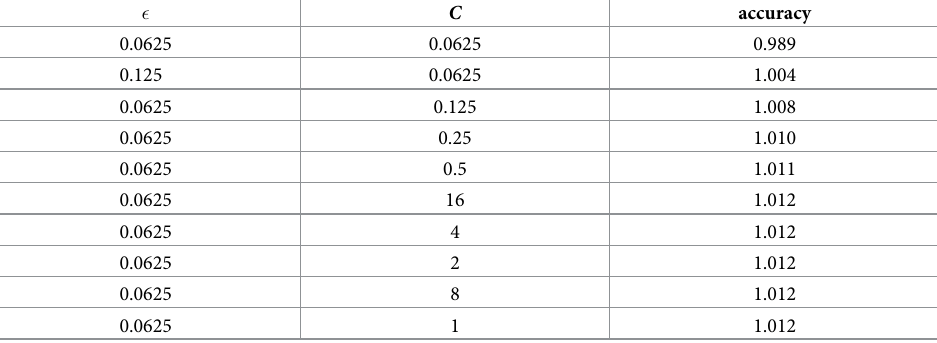
3-feature classification described in the previous section is assumed to stratify patients. Data are organized in a table where rows correspond to samples (the patients) and columns to fea- tures (data from Prosafe along five years). The target value is the LoS. A pre-processing phase is required to: ( i ) transform categorical features into binary features; ( ii ) scale feature values; and ( iii ) identify correlation between data. The tools used are: SVR with linear kernel for pre- diction, k -fold cross-validation with k = 3 for validation, and Relieff [35] for features ranking. The Mean Absolute Error (MAE) is used to measure solution quality. For each patient class, we use 4/5 of the data for the training phase and 1/5 for the test phase. Only classes with at least 50 patients have been considered. As an example, Table 4 reports the MAE value (aver- aged over the folds) obtained for the best ten configurations of parameters � and C used in the validation phase for the largest class in the database (872 patients), i.e. elective surgery, medium care intensity, no ventilation. The accuracy obtained in test phase for the best performing parameter configuration (first row in the table) is equal to 1.16 days. The feature selection reveals that with only 6 of the 143 features characterizing patients in this class the accuracy can even improve to 1 days. Specifi- cally, the 6 key features seem to be the following: average blood pressure, digestive tract perfo- ration, surgical department from which the patient comes, metabolic failure, vascular abdominal surgery, and type-2 diabetes. Table 4. Results of LoS prediction for the ElectiveSurgery_MediumCareIntensity_NoVentilation class—SVR with 3-fold